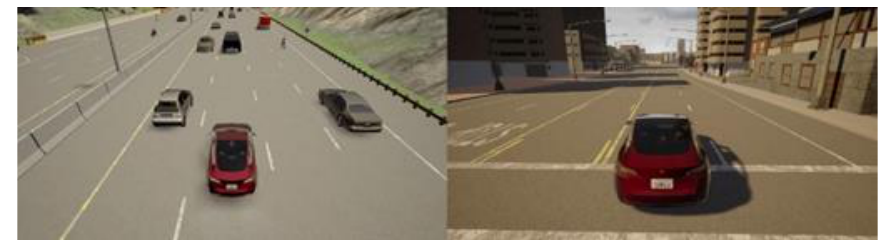
Figure 12. CARLA simulation